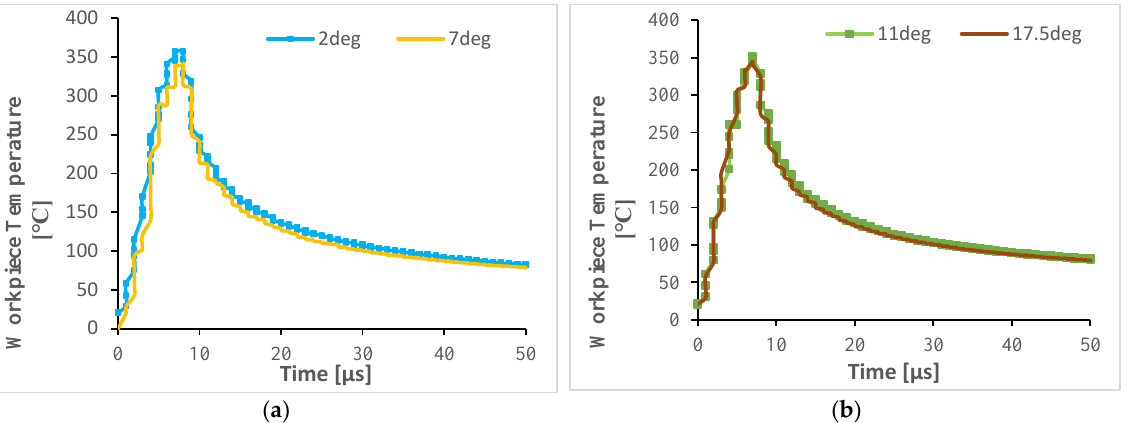
Figure 20. Effect of clearance angle on cutting temperature (r ε = 20 µm and γ = 17.5°): ( a ) 2–7 ° and ( b ) 11–17.5°.